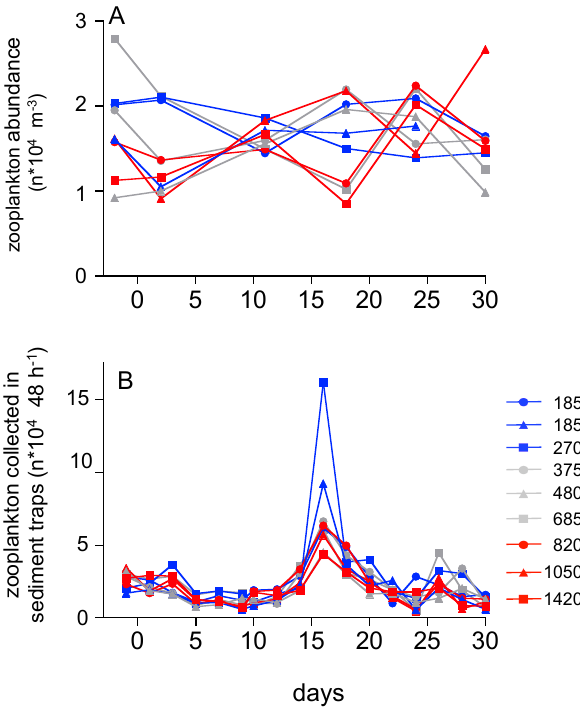
Fig. 1. Total mesozooplankton abundance in the water column (A) and in the sediment traps (B) of nine mesocosms with different CO 2 levels. The numbers in the legend present initial CO 2 concentrations (µatm) after the CO 2 manipulation was completed.